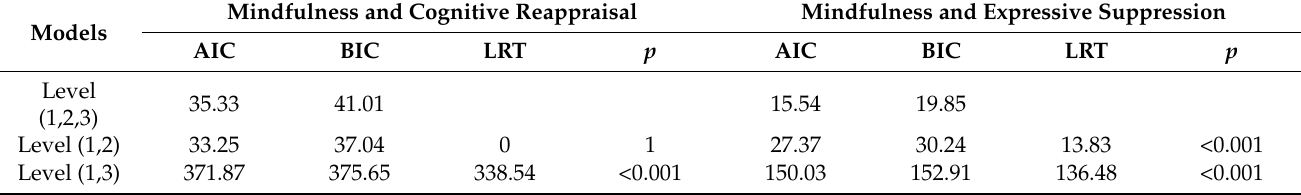
Table 2. Comparison between the three-level random effects model and the two-level random effects